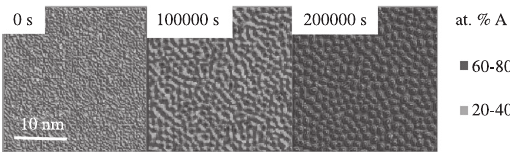
Figure 10. Microstructural evolution for B-30at.%A alloy for = 16628 J/mol at 650 K. Ω A-B